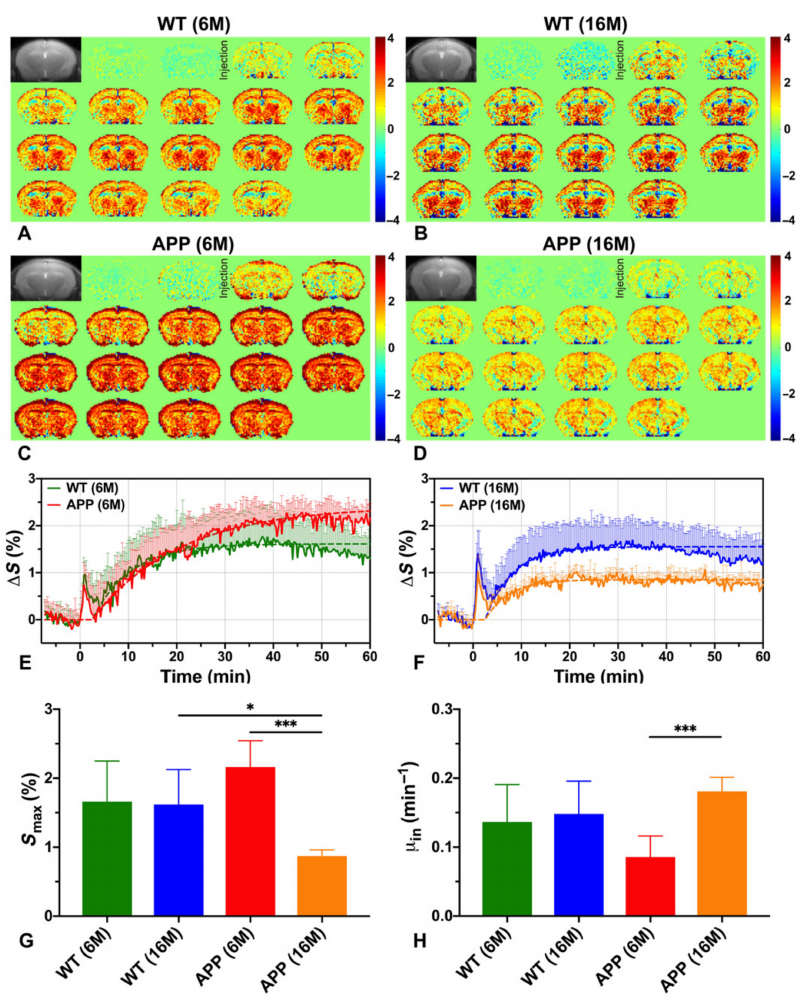
Figure 5. GlucoCEST imaging: Dynamic Glucose Enhancement (DGE) MRI results for brain parenchyma of WT and APP/PS1 mice. Dynamic difference images before and after D-glucose infu- sion for WT ( A , B ) and APP/PS1 ( C , D ) mice at 6 M ( A , C ) and 16 M ( B , D ). DGE images were averaged over sets of 15 for display (18 of 270). Experimental (solid line) and fitted (dashed line) parenchymal DGE curves for WT (6 M, n = 5) and APP/PS1 (6 M, n = 5) mice ( E ), as well as WT (16 M, n = 5) and APP/PS1 (16 M, n = 5) mice ( F ). Comparison of fitted uptake parameters S max ( G ) and µ in ( H ) between WT and APP/PS1 mice for two age groups (6 M and 16 M). Significance levels: * p < 0.05 and *** p < 0.001. Reprinted from [180]. © Huang et al., some rights reserved; exclusive licensee AAAS. Distributed under a CC BY-NC 4.0 license http://creativecommons.org/licenses/by-nc/4.0/ (access date 21 September